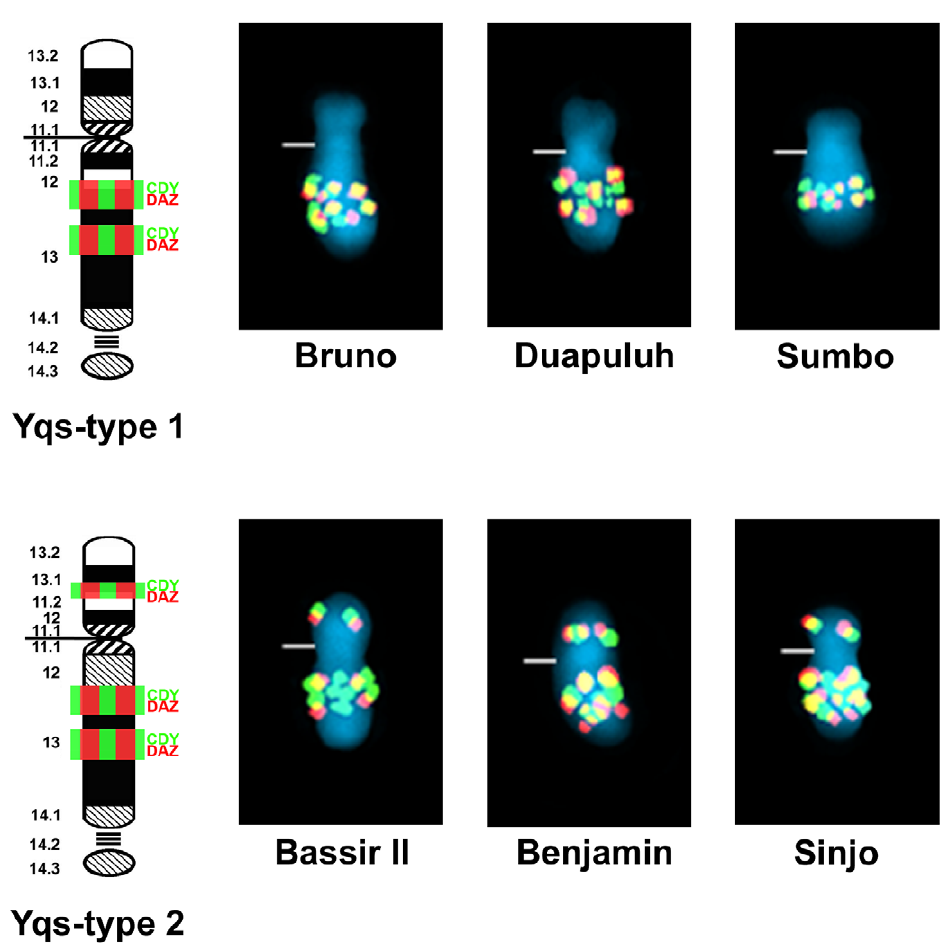
Figure 3. FISH mapping of ampliconic genes DAZ and CDY on Y chromosomes of Sumatran orangutan. FISH patterns for DAZ (red) and CDY (green) illustrated for Sumatran orangutans ‘‘Bruno’’, ‘‘Duapuluh’’ and ‘‘Sumba’’ showing Yqs-type 1, as well as ‘‘Bassir II’’, ‘‘Sinjo’’ and ‘‘Benjamin’’ showing Yqs-type 2. The band locations of each gene are shown on the ideogram to the left. Yellow signals result from overlapping of red and green signals. Centromeres are marked by horizontal lines. Band nomenclature follows the ISCN [71].